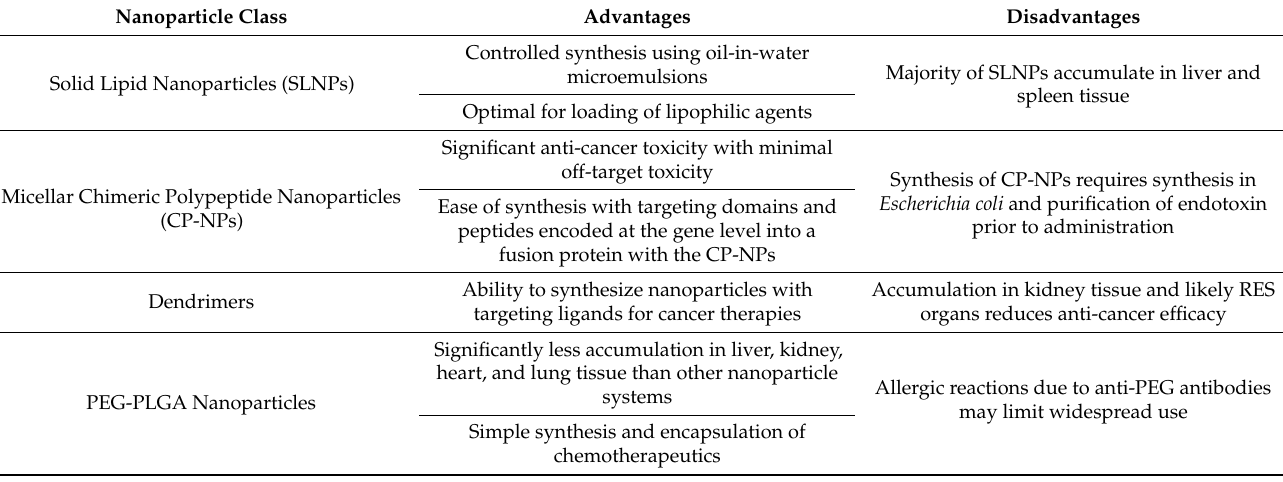
Table 3. Advantages and Disadvantages of Polymeric Nanoparticles for Cancer